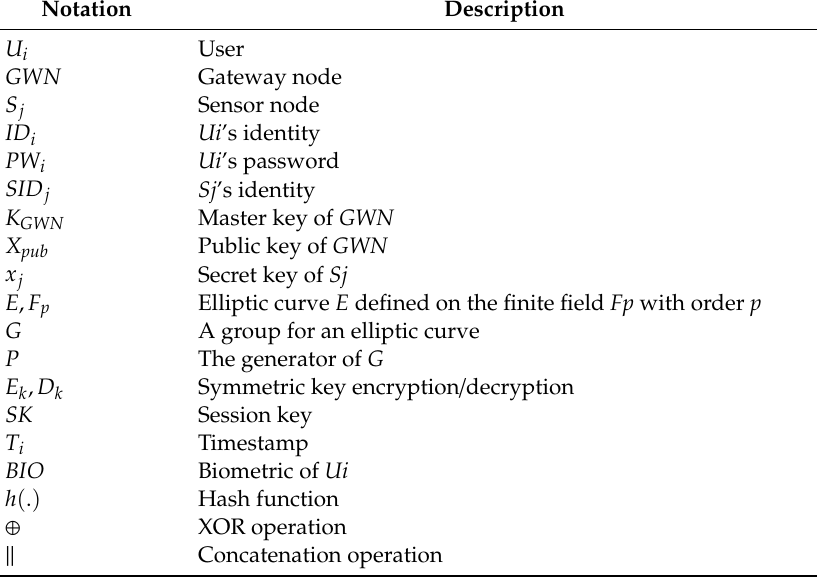
Table 1. Symbols used in Yu and Park